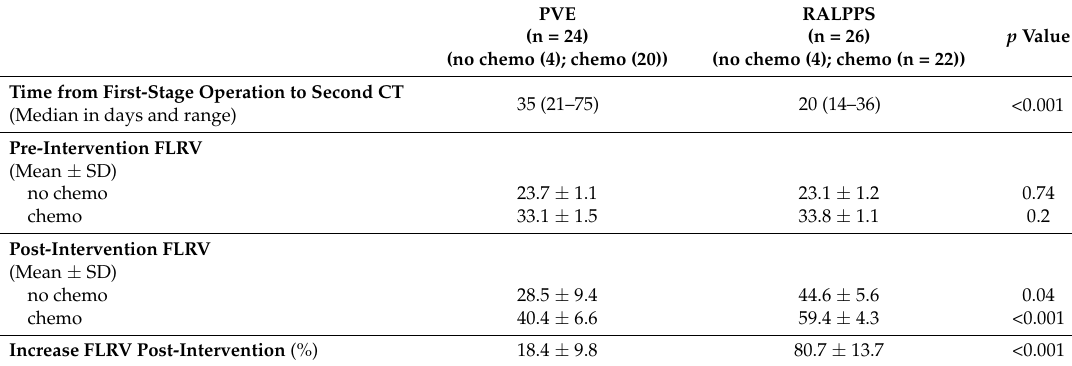
Table 3. FLRV before and after PVE or